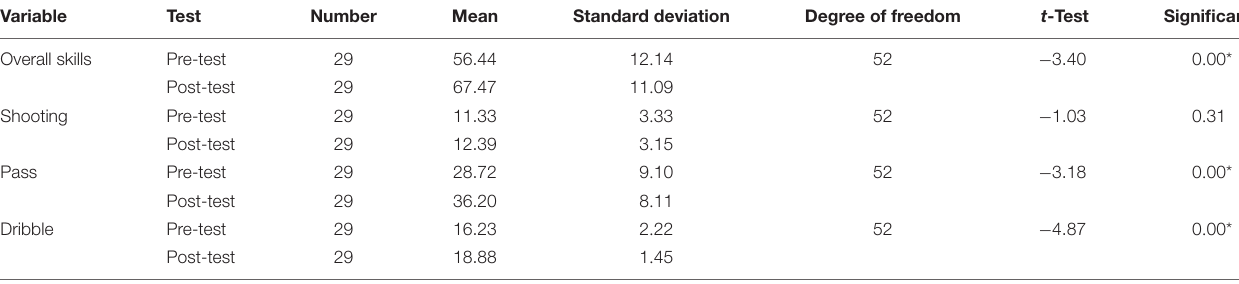
TABLE 8 | The basketball skill performance pre-test and post-test repeated measurement t- test analysis of the experimental group. Variable